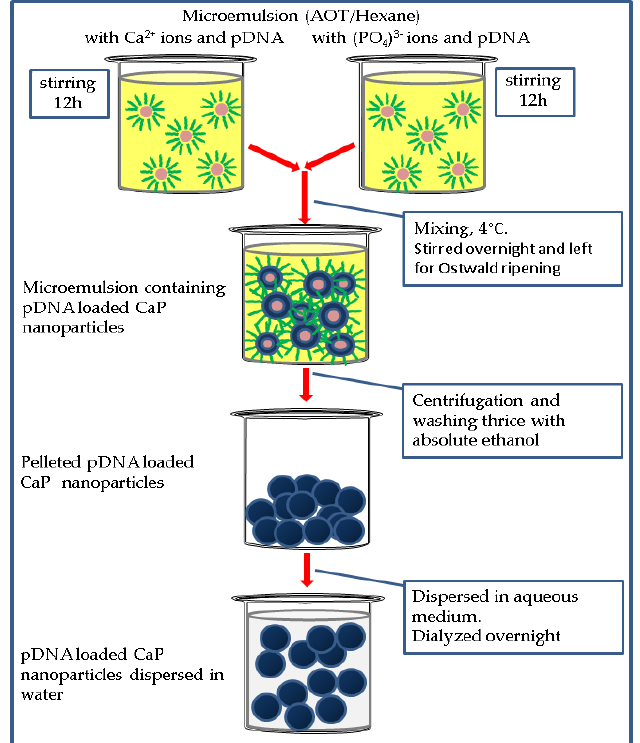
Figure 8. Flow chart showing the formation of nanoparticles encapsulating pDNA in the aqueous core of the bis (2-ethylhexyl) sulfosuccinate surfactant (AOT) microemulsion in hexane. The strategy involved the precipitation of the CaP in the aqueous core of the microemulsion droplets in the presence of pDNA. Adapted from [111], Elsevier, 2004.